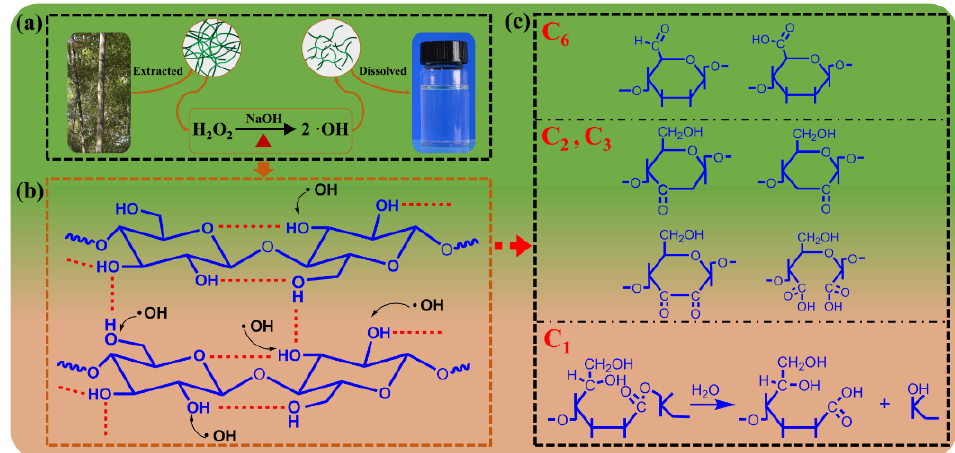
Figure 2. ( a ) Bamboo pulp with high M η converted into low bamboo pulp with high solubility through one - step processing ( a ). ( b ) The reaction of ·OH with hydroxyl groups in cellulose chains and various cellulose oxidation products ( c ).